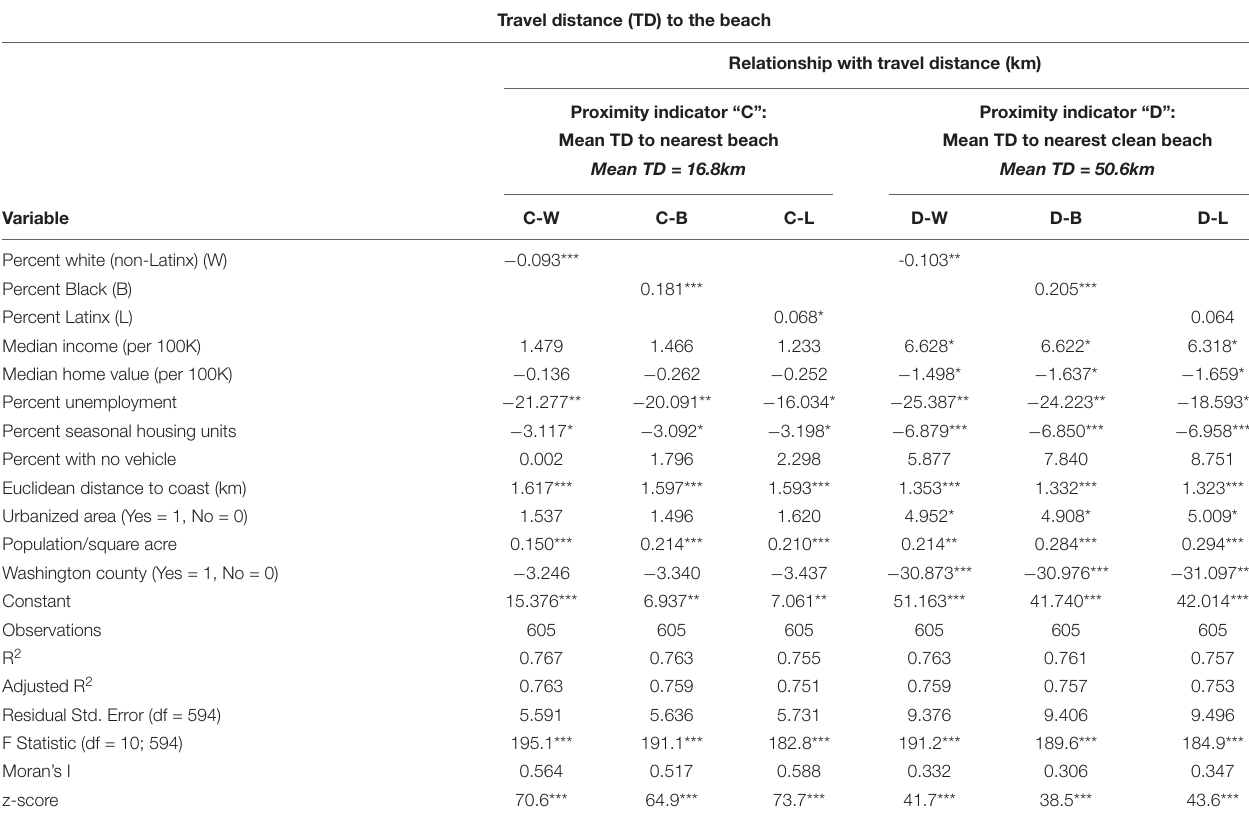
TABLE 5 | Linear regression results for proximity indicator (C) mean travel distance (TD) in kilometers to the nearest public swimming beach and (D) mean TD to the nearest clean beach, each run separately for race/ethnicity variables percent non-Latinx white (W), percent Black (B), and percent Latinx (L). Travel distance (TD) to the